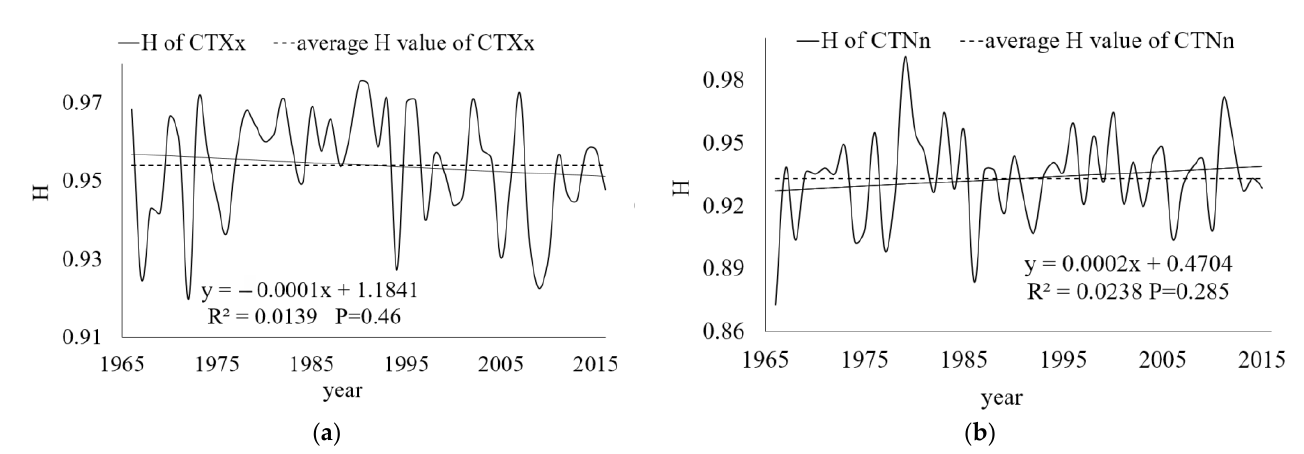
Figure 11. Temporal variation of H values for CTXx and CTNn in China, 1966 – 2015. ( a ) CTXx. ( b )